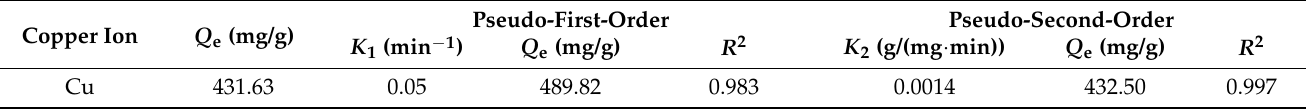
Figure 13. Pseudo-first-order ( a ), and pseudo-second-order ( b ), linear fitting of dynamics.